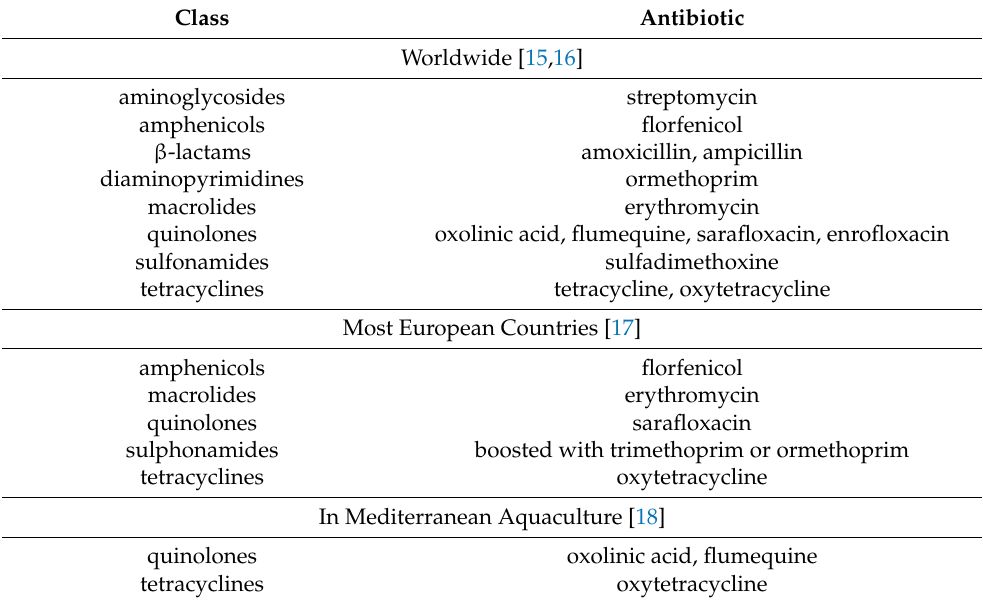
Table 1. The most commonly used antibiotics in